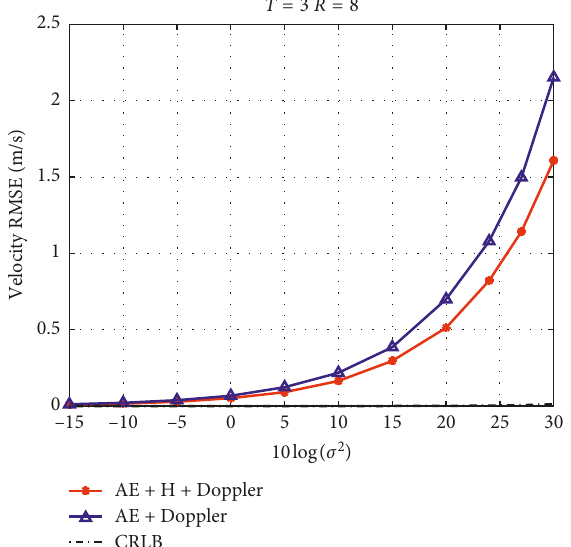
Figure 7: Comparison of the velocity RMSE of the proposed method with AE+Doppler and CRLB when T � 3, R � 8. The CRLB is close to zero, but it is going up as the noise power increases.